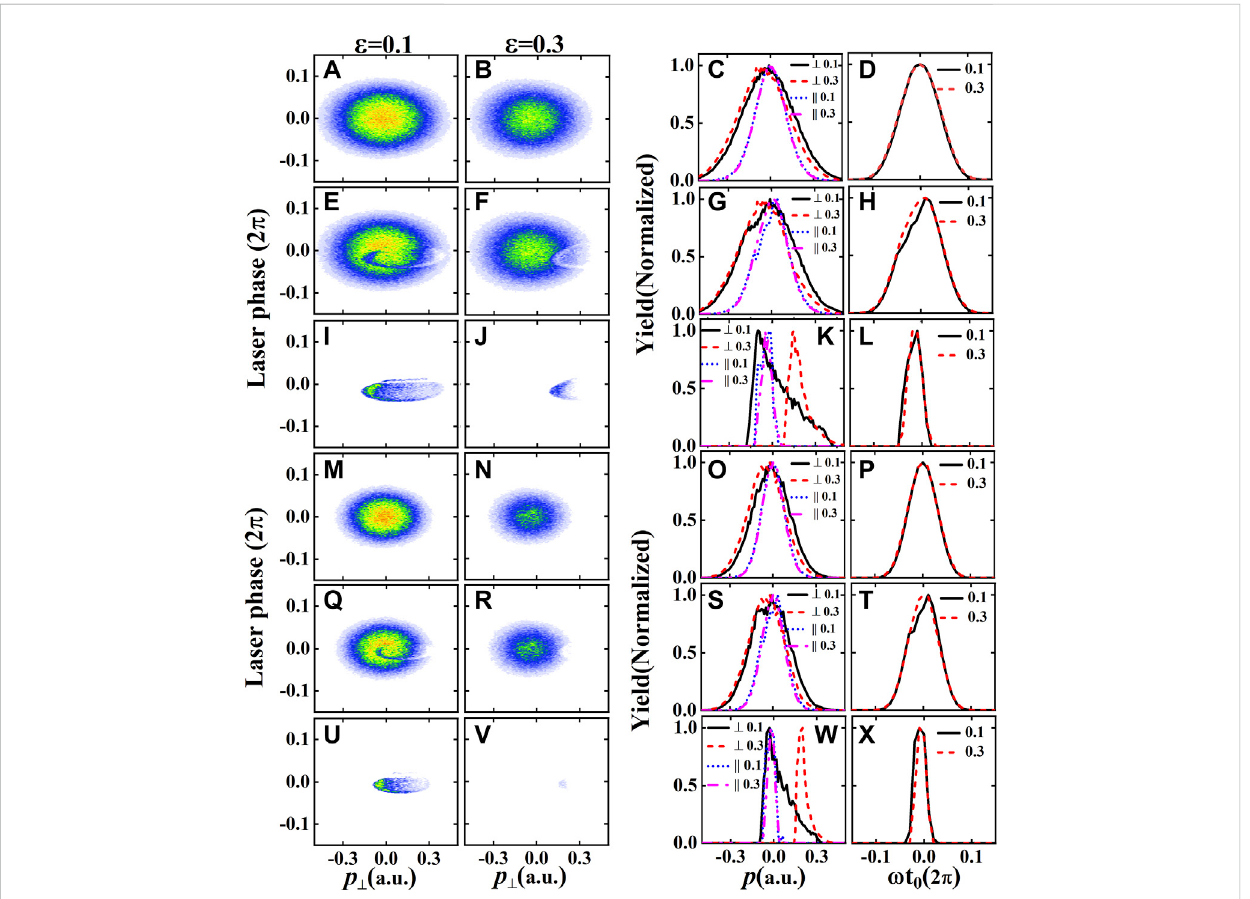
FIGURE 5 Thelaserphasedependenceoftheinitialphotoelectrontransversemomentumdistributionsfortunneling (A,B,M,N) ,ionization (E,F,Q,R) andRSE (I,J,U,V) processesattheellipticitiesof ε =0.1 (A,E,I,M,Q,U) and ε =0.3 (B,F,J,N,R,V) .Theinitialphotoelectrontransversemomentumdistributionsin (C, G, K, O, S, W) and laser phase distributions in (D, H, L, P, T, X) are extracted from the data of (A, B , (E, F, I, J, M, N, Q, R, U, V) , respectively. The initial photoelectronlongitudinalmomentum distributions for tunneling (C,O) ,ionization (G, S) and RSE (K, W) are also presented. The laser intensities are 1.6×10 14 W/cm 2 (A – L) and 0.4×10 14 W/cm 2 (M – X) . The laser wavelengthes are 800 nm (A – L) and 1,600 nm (M – X) . These data are calculated by the nonadiabatic